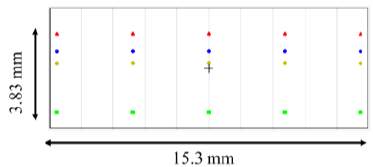
Figure 14. Footprint Diagram of the image plane Spot diagram of the overall HSI design is shown in Figure 15.